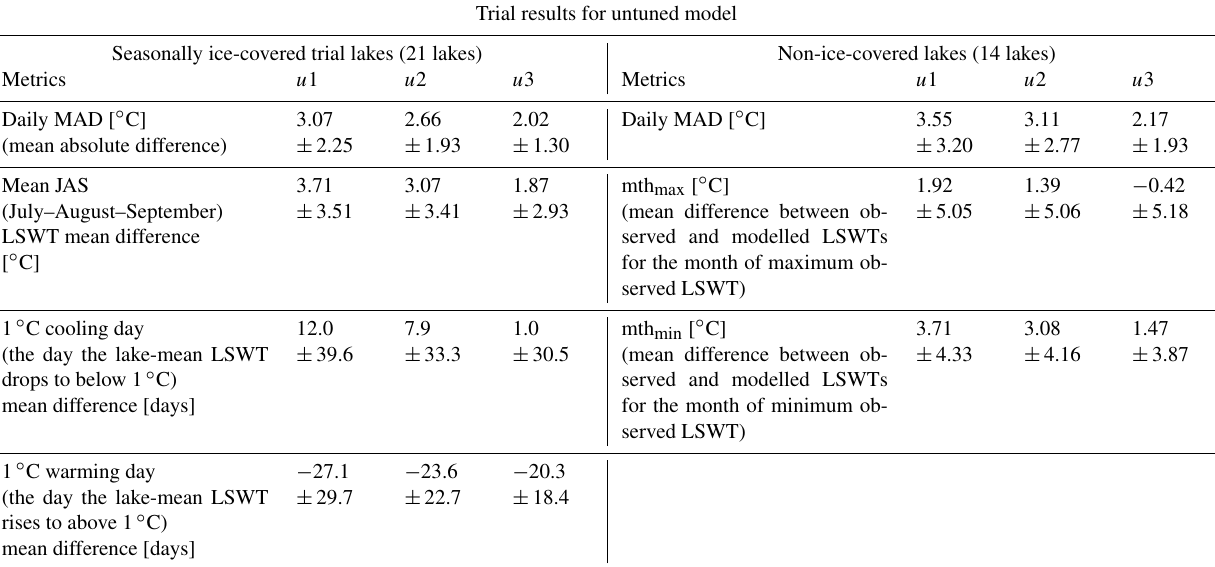
Table 4. The effect of wind speed scaling on untuned modelled LSWTs, presented as the mean difference, between the modelled and observed values, across lakes with the spread of differences defined as 2 σ , where wind speeds u 1 is unscaled, u 2 is factored by 1.2 and u 3 ( U water = 1 . 62ms − 1 + 1 . 17 U land ). Results are presented for seasonally ice-covered and non-ice-covered trial lakes. Results highlight that u 3 is most applicable to seasonally ice-covered lakes but there is no one wind speed most suited for all lakes (while the mean difference is improved with u 3, the spread of the mean differences across lakes for mth min and mth max show little change). Units are given in square